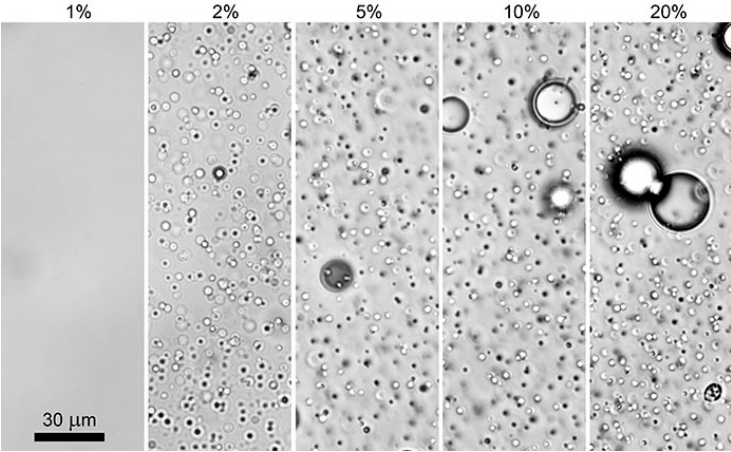
Figure 3. The morphology of mixtures of PAN solutions containing various amounts of HMDSO.